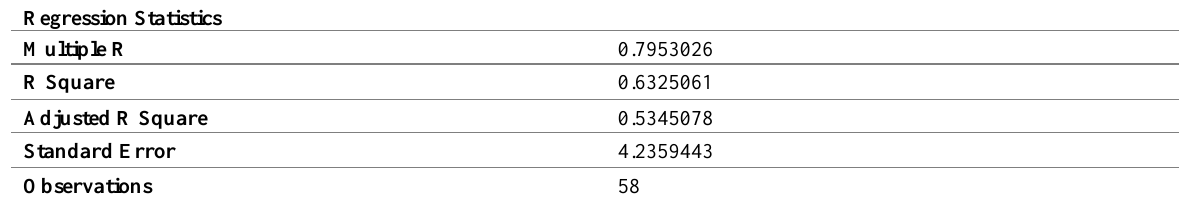
Table 22: Regression Statistics (Rangpur Division)